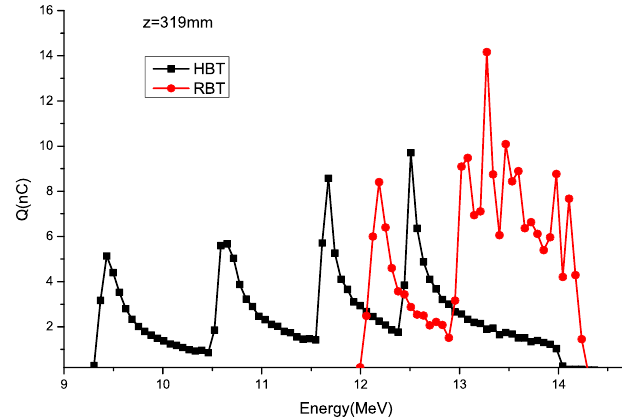
FIG. 11. Distribution functions of drive bunch particles after traveling 319 mm for the HBT (black symbols) and for the RBT (red symbols). The leftmost peak of the distribution function of the RBT is determined by the fourth